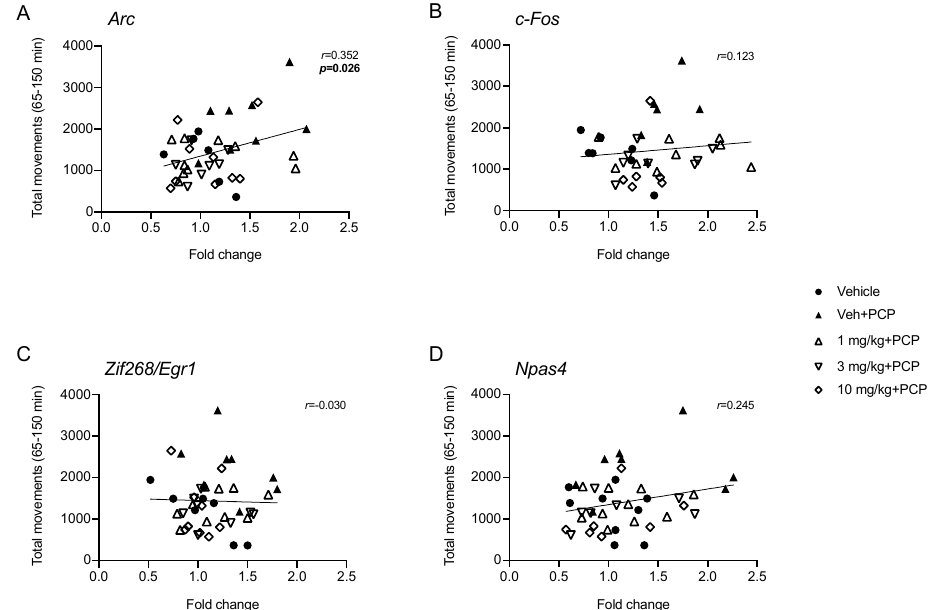
Figure 4. Pearson product–moment correlation ( r ) between the total counts measured in the second part of the test (65–150 min) and gene expression of Arc ( A ), c-Fos ( B ), Zif268/Egr1 ( C ) and Npas4 ( D ) following PCP injection. The statistical significance was assumed with p < 0.05.